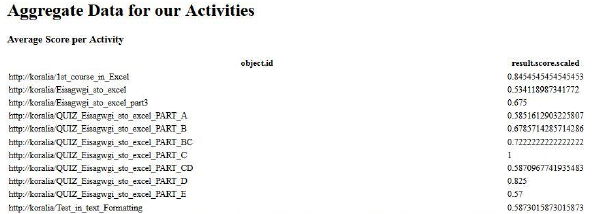
Figure 13. Average score per Activity